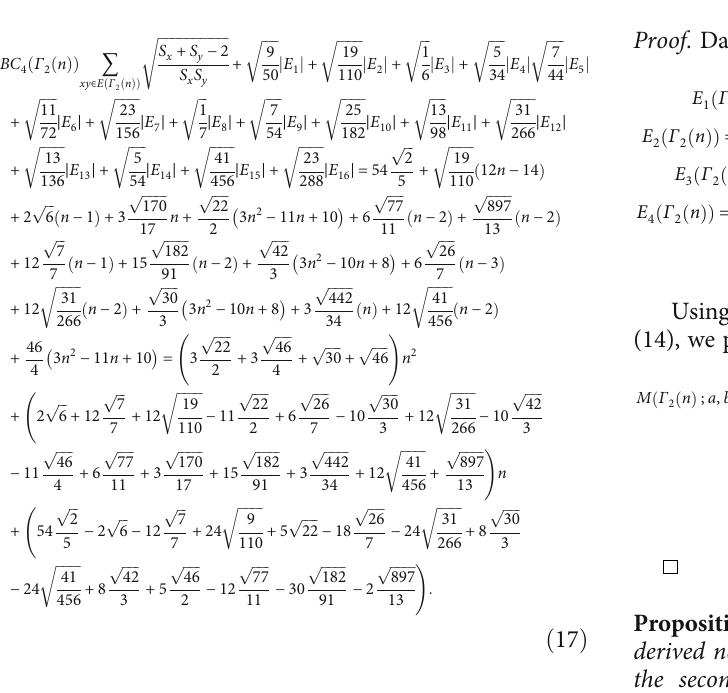
Figure 6: Comparison of Γ of